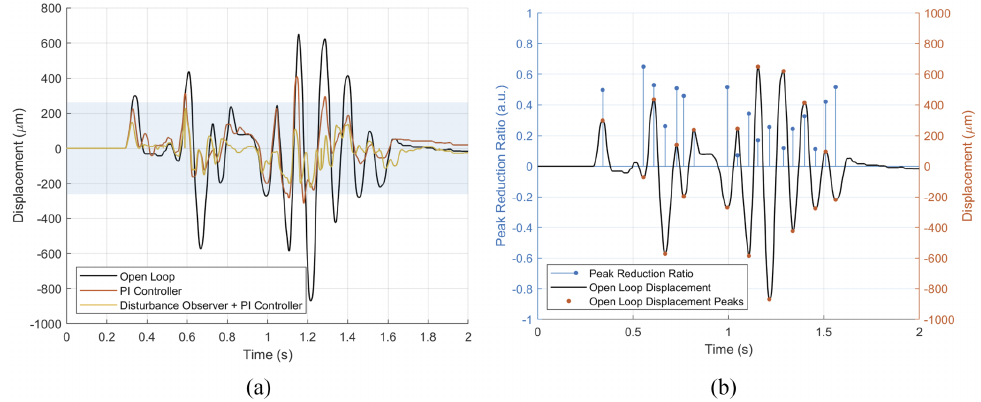
Figure 17. Disturbance observer-based controller result. ( a ) The open loop displacement (black curve), PI controller displacement (red curve), and DOBC displacement (yellow curve) are plotted together for comparison with a blue rectangular region that shows the 30% maximum open loop displacement threshold. ( b ) The black curve is the open loop displacement, the red dots are the open loop displacement peaks, and the blue dots are the ratio between the controlled displacement peaks and the open loop